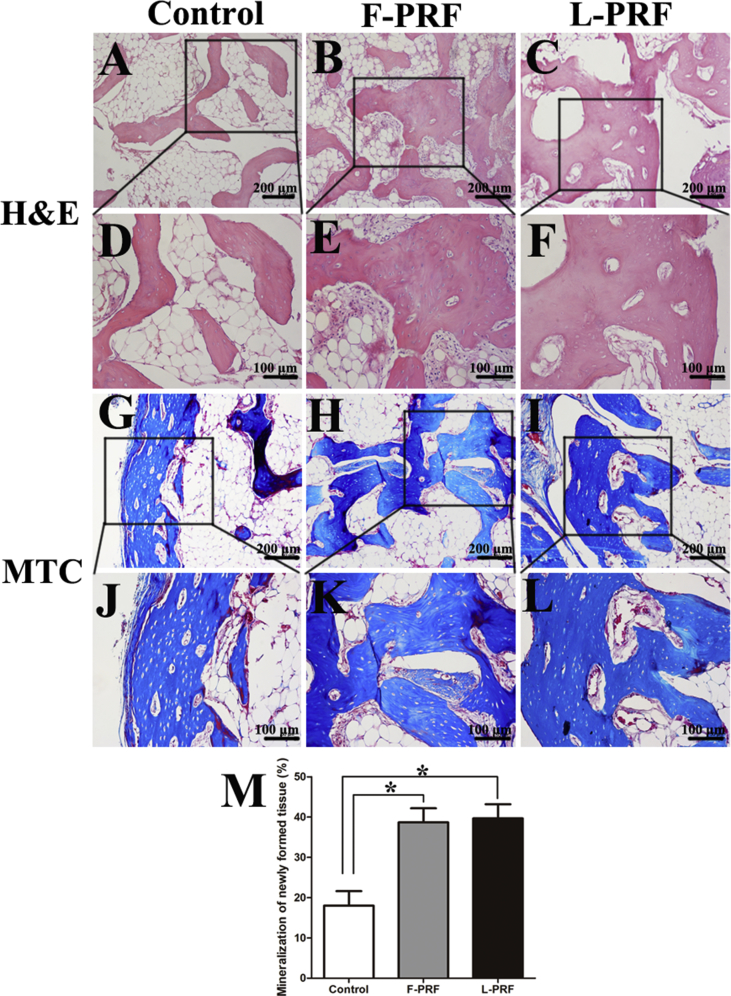
Histological analysis of newly formed bone tissue. HE staining. (A) Compared with the PRF groups, the control group showed fewer newly formed island-like bone tissue structures (scale bar = 200 μm). (B, C) A large number of interconnected ossified trabeculae and woven bone structures were observed in the F-PRF (B) and L-PRF (C) groups (scale bar = 200 μm). (D) A high-magnification image indicated that the newly formed bone and cartilage-like tissues were sparse and unevenly distributed in the control group (scale bar = 100 μm). (E, F) Osteoblasts were observed in the newly mineralized tissue, osteocytes were embedded in the dense matrix, and primary bone marrow was observed in the F-PRF (E) and L-PRF (F) groups (scale bar = 100 μm). (C–L) Masson's trichrome staining showed that the F-PRF (H, K) and L-PRF (I, L) groups exhibited more osteogenesis than the control group (G, J) (scale bar = 200 μm in G, H, and I, and scale bar = 100 μm in J, K, and L). (M) Histomorphometrical examination of the specimens indicated that mineralized bone and cartilage occupied 38.7 ± 3.9 and 39.6 ± 4.2% of the total cross-sectional areas of the specimens in the F-PRF and L-PRF groups, respectively (P = 0.09). However, the percent area of new bone and cartilage in the control group (18.2 ± 2.3%) was significantly less than that observed in the F-PRF and L-PRF groups at eight weeks postimplantation (P = 0.01) (*P < 0.05).